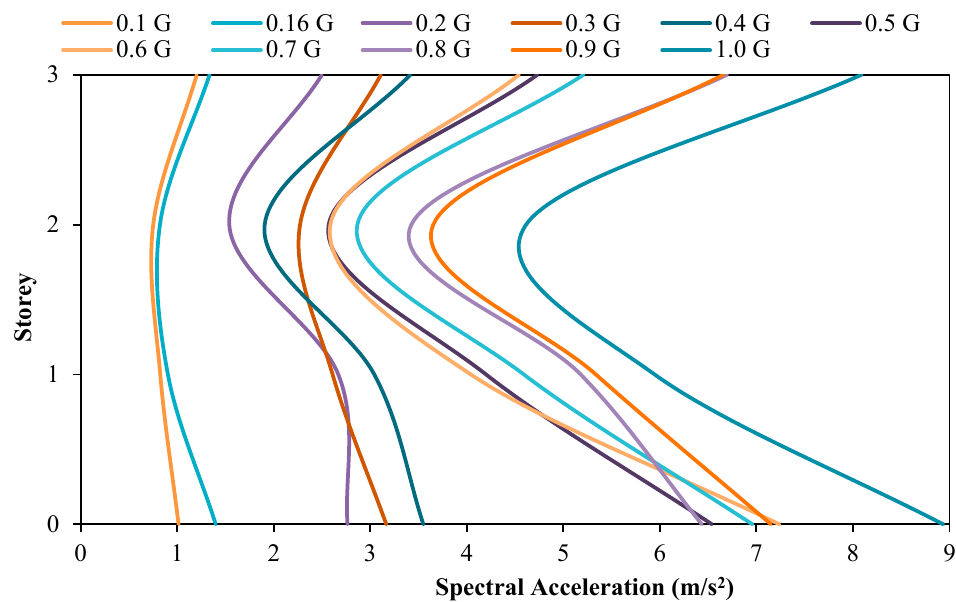
Figure 8. Spectral acceleration of structure with dampers.